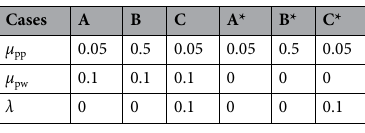
Table 3. Parameters in 6